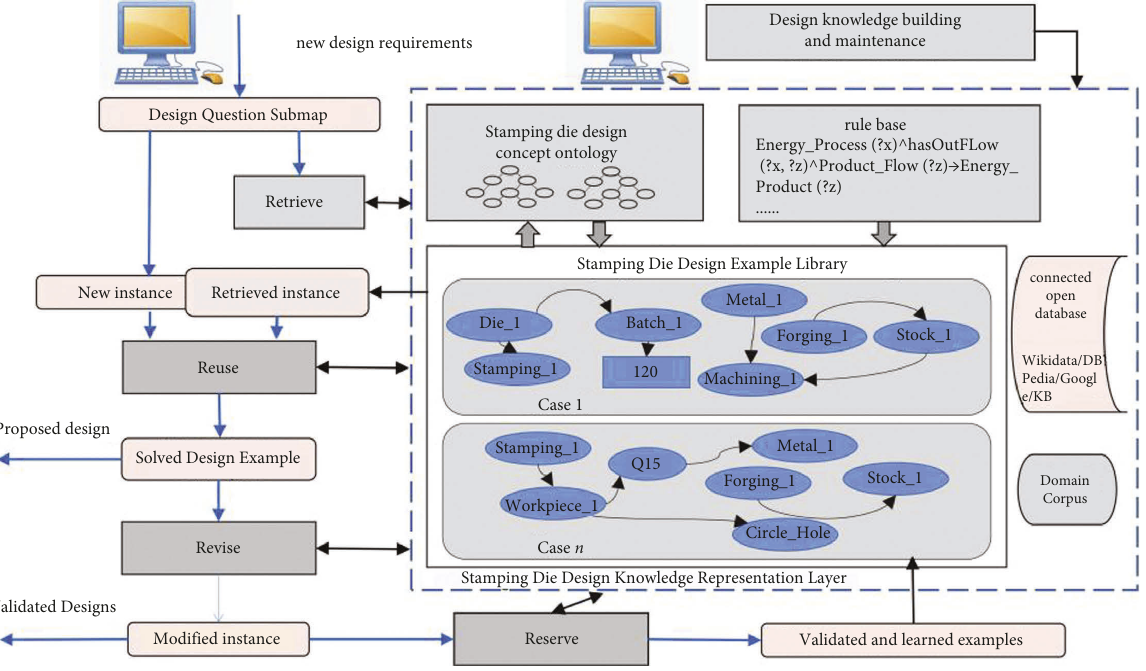
Figure 8: Overall